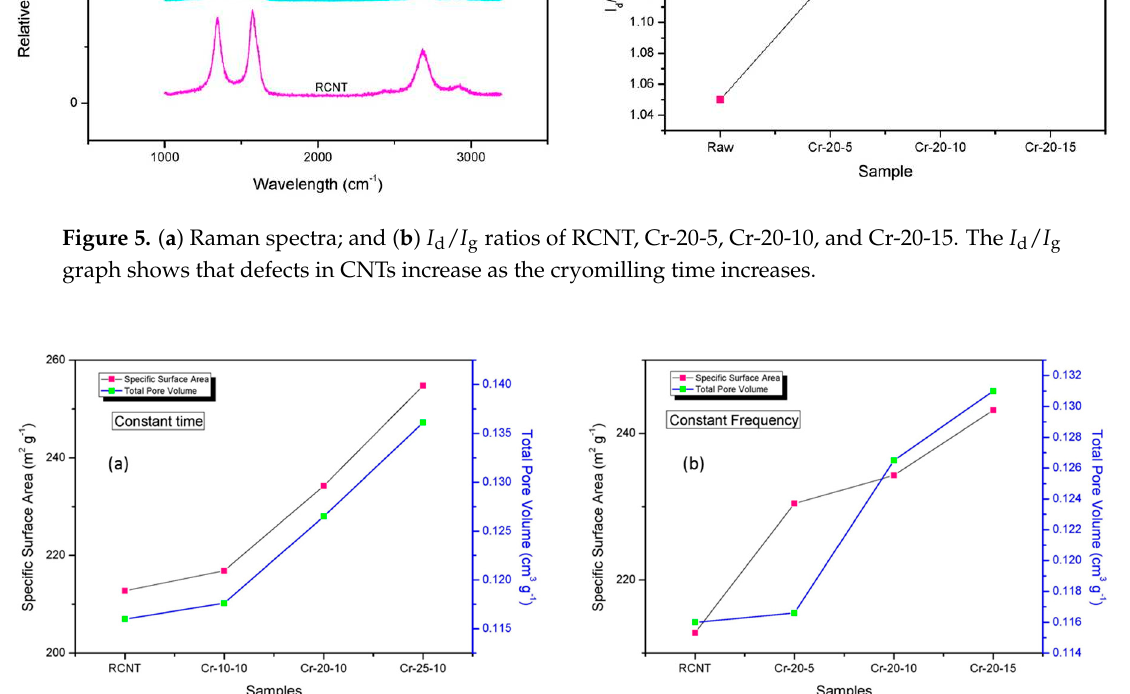
Figure 6. Specific surface area and total pore volume of the ( a ) RCNT, Cr-10-10, Cr-20-10, and Cr-25- 10; and ( b ) RCNT, Cr-20-5, Cr-20-10, and Cr-20-15 samples. The samples Cr-25-10 and Cr-20-15 showed the highest specific surface area and highest average pore volume.